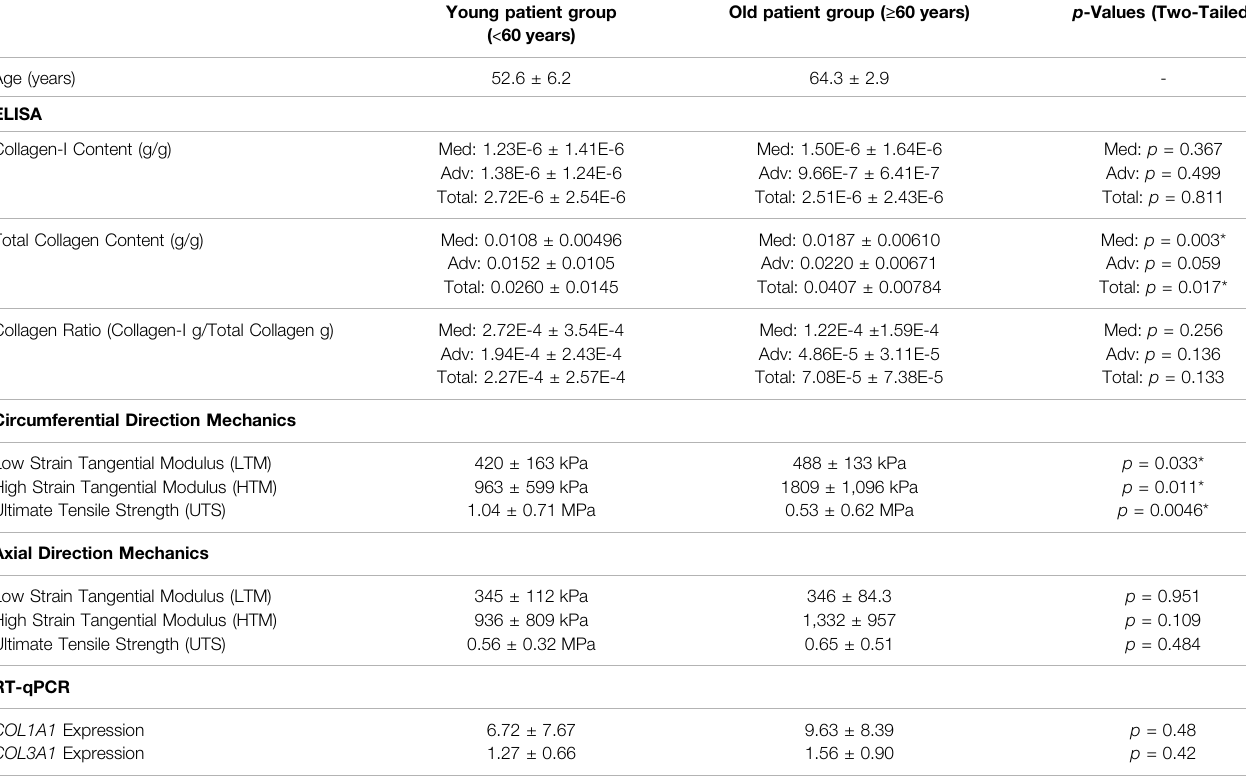
TABLE 2 | Comparison of the collagen-I content, total collagen content, and mechanical properties between young ( < 60) and old ( ≥ 60) patient groups. Young patient group ( < 60